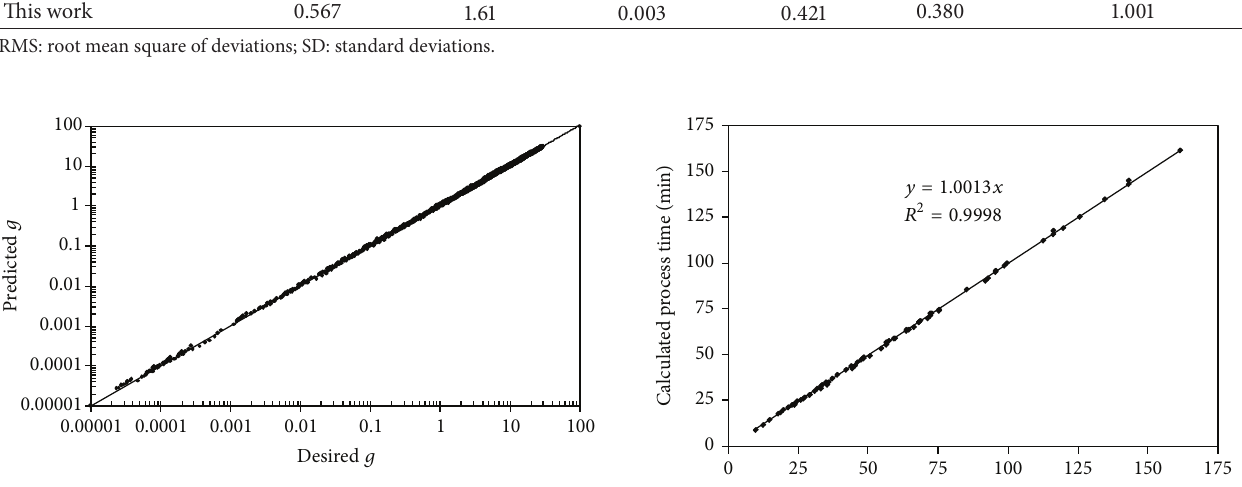
Figure 4: Values of 𝑔 predicted using the mathematical model versus desired Stumbo’s values of 𝑔 .